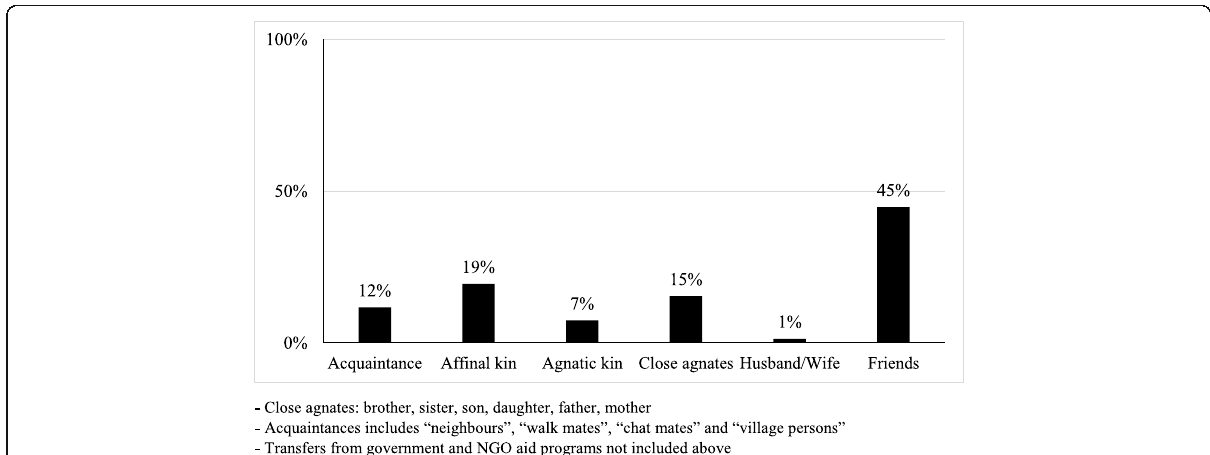
Fig. 2 All exchanges in 2015 in both field sites by relationship categories. Close agnates: brother, sister, son, daughter, father, mother. Acquaintances includes “ neighbours ” , “ walk mates ” , “ chat mates ” , and “ village persons ” . Transfers from government and NGO aid programs not included